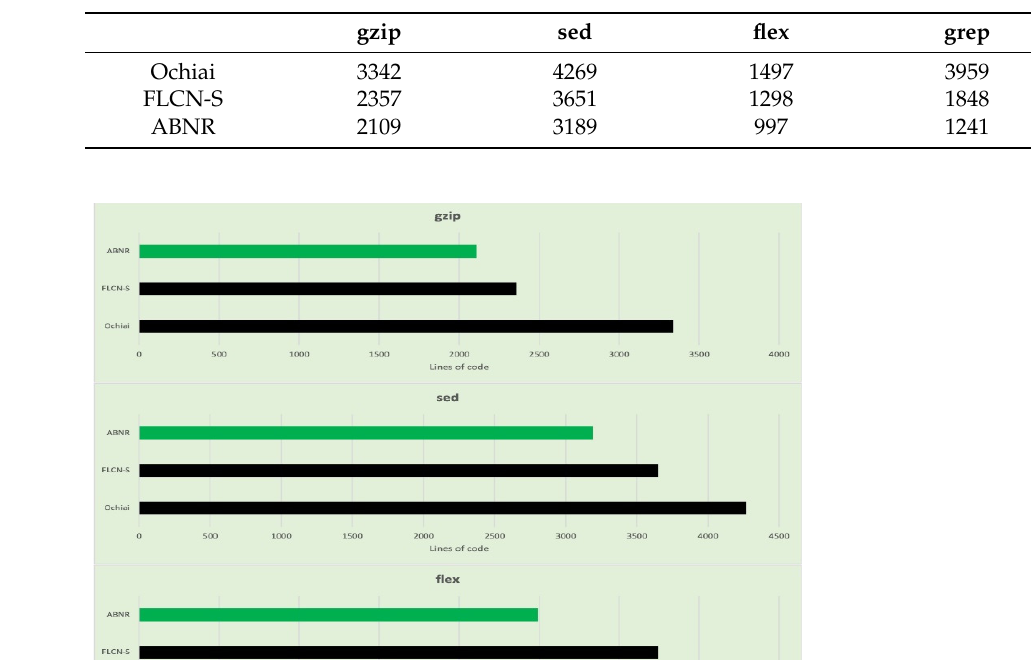
Table 7. Denotes the number of statements analyzed for fault detection in Unix utility applications.